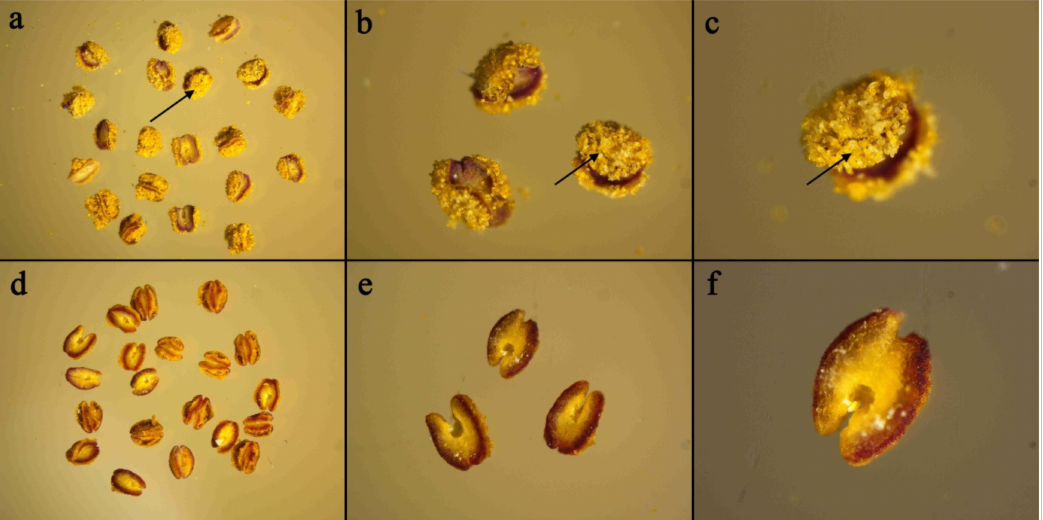
Figure 1. The anther observation of the peach fertile/sterile phenotype under different magnifications. The black arrows indicate the mature pollen grains. ( a – c ) indicate the fertile phenotype with abundant pollen grains in the naturally dried anthers. ( d – f ) indicate the sterile phenotype with no pollen grains observed.